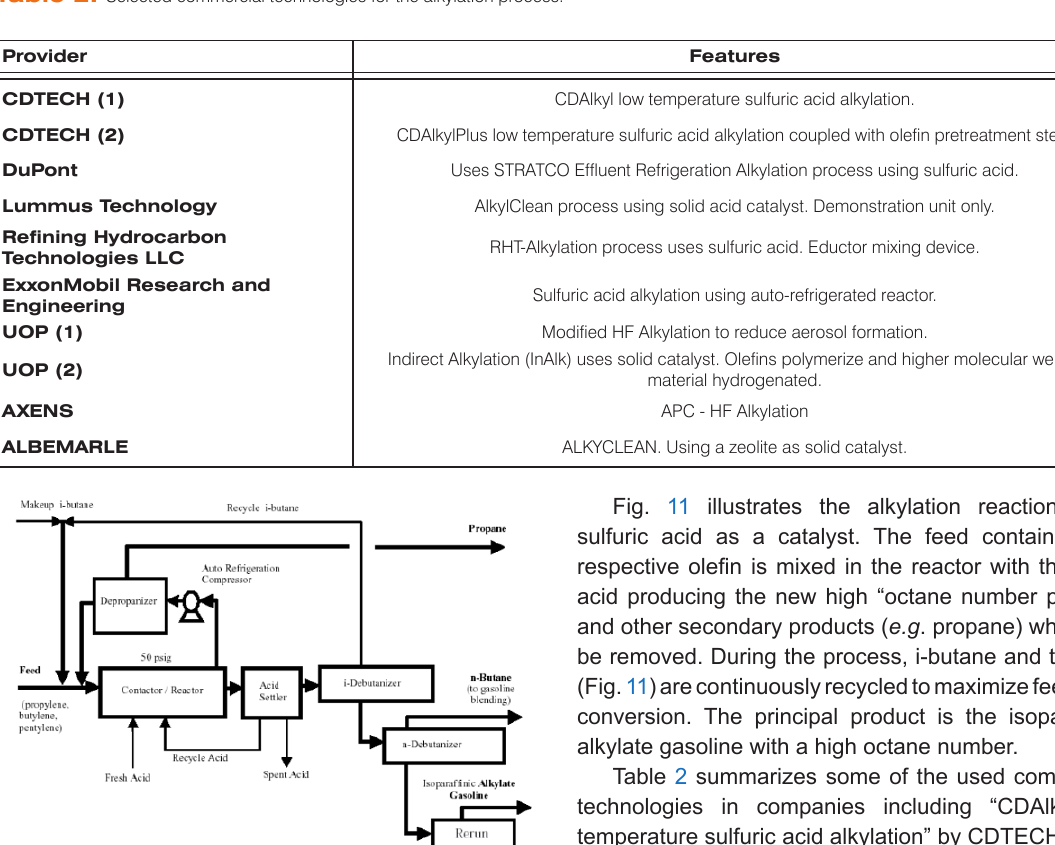
Table 2. Selected commercial technologies for the alkylation process.